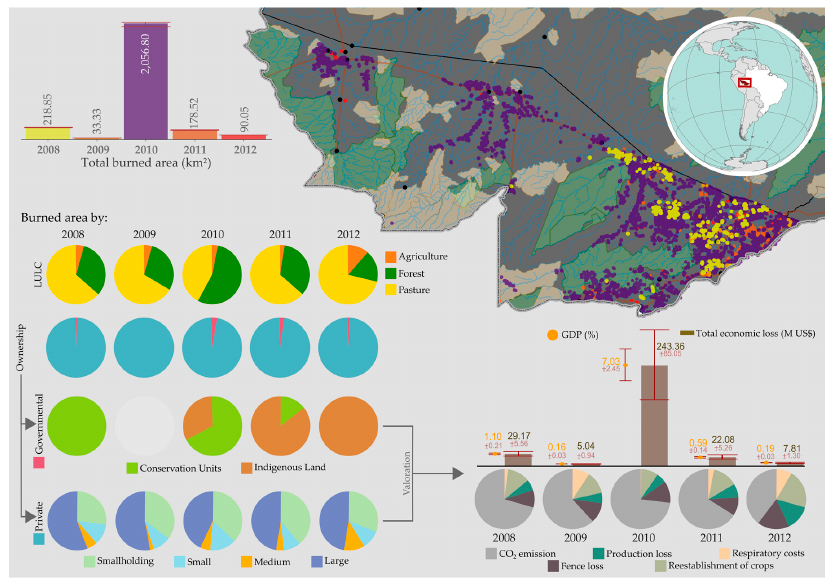
Figure A3. Graphical Abstract.